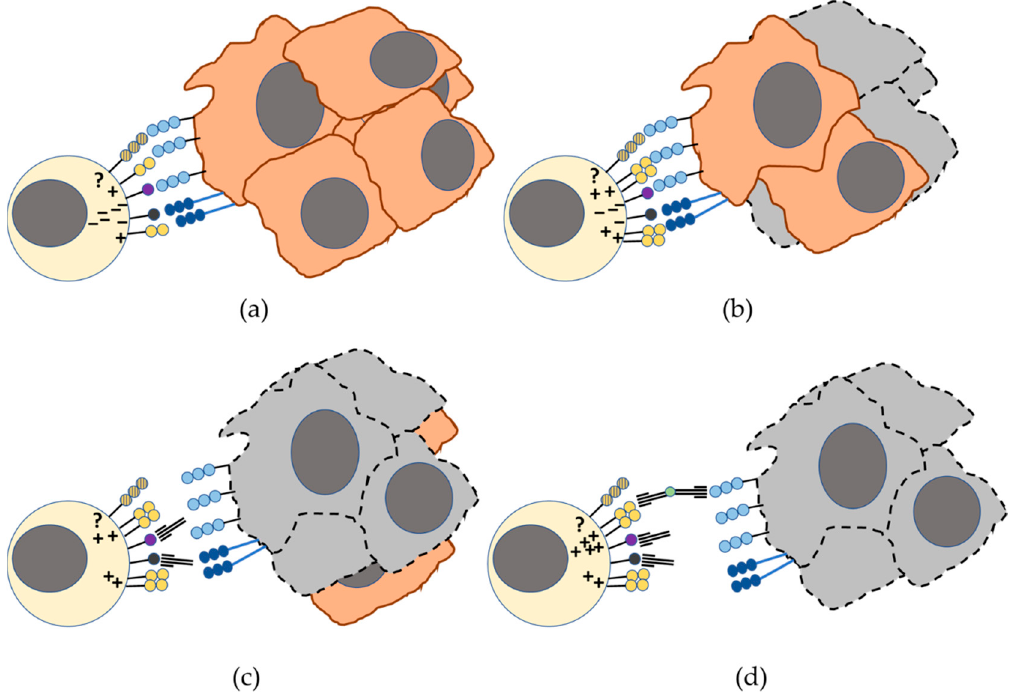
Figure 3. DNAM-1 / TIGIT / PVRIG / TACTILE axis in the recognition of tumor cells by NK cells. ( a ) The activation signals mediated by DNAM-1 (represented in yellow) recognition of its ligands, CD155 (represented in light blue) and CD112 (represented in dark blue), can be counteracted by inhibitory signaling through TIGIT and PVRIG inhibitory receptors (represented in purple and dark grey). In humans, the role of TACTILE (represented in shaded-yellow) in this balance requires a more detailed analysis. ( b ) Overexpression of DNAM-1 can induce lysis of some tumor cells but fails to eliminate the tumor. ( c ) TIGIT or PVRIG checkpoint blockade improves the responses mediated by DNAM-1 contributing to tumor elimination. ( d ) The combination of one or two checkpoint mAbs with co-stimulatory bispecific mAb (e.g., anti-DNAM-1 × anti-CD155) may result in better antitumor immune responses by increasing the interaction of DNAM-1 with its ligands. Cells surrounded by dotted lines represent dead cells.